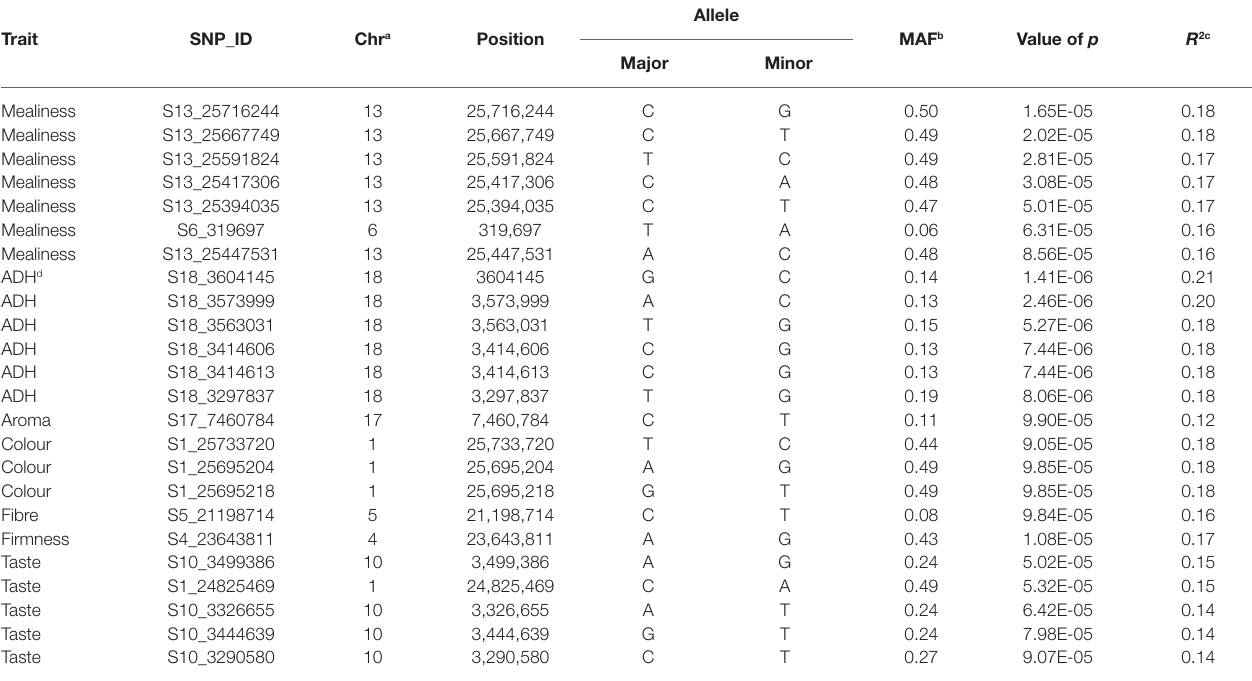
TABLE 2 | Summary statistics of top significant SNPs at each major trait linked locus for root mealiness and other textural attributes of boiled cassava roots.